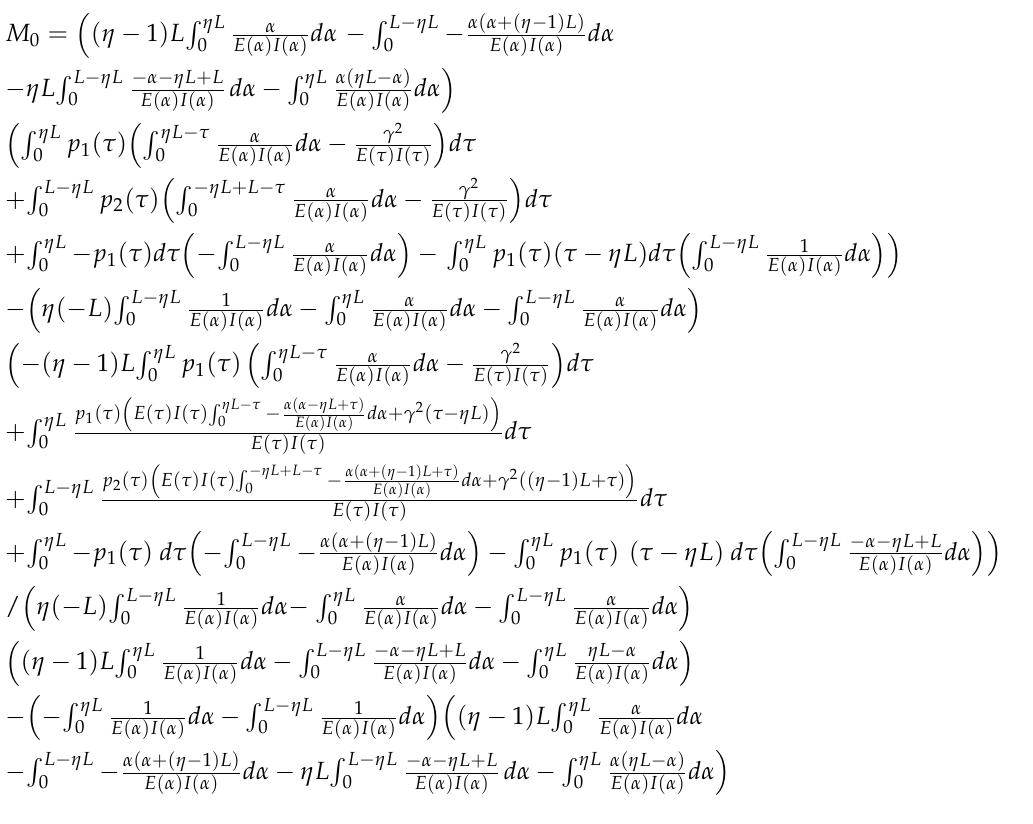
The variation of the end moment ( L M ) in classical and nonlocal theory with respect γ ratio is given in Figure 5b. to the L Figure 6. A fi xed beam with both ends subjected to the two di ff erent distributed loads. Figure 6. A fixed beam with both ends subjected to the two different distributed loads. The other two initial values are found with the help of Equation (15) as A fi xed beam with both ends subjected to the two distributed loads is shown in Figure 6. In this case, the initial values and end conditions are